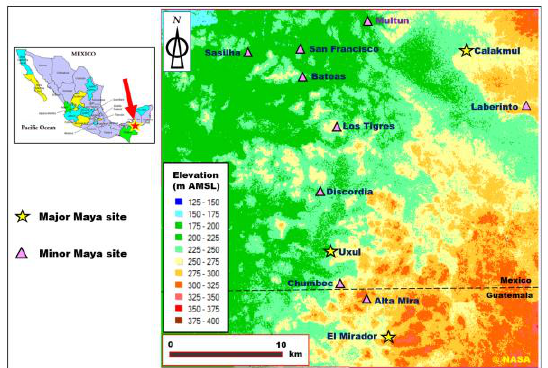
Figure 2. Location of the study area, associated elevation map, and location of some known ancient Maya